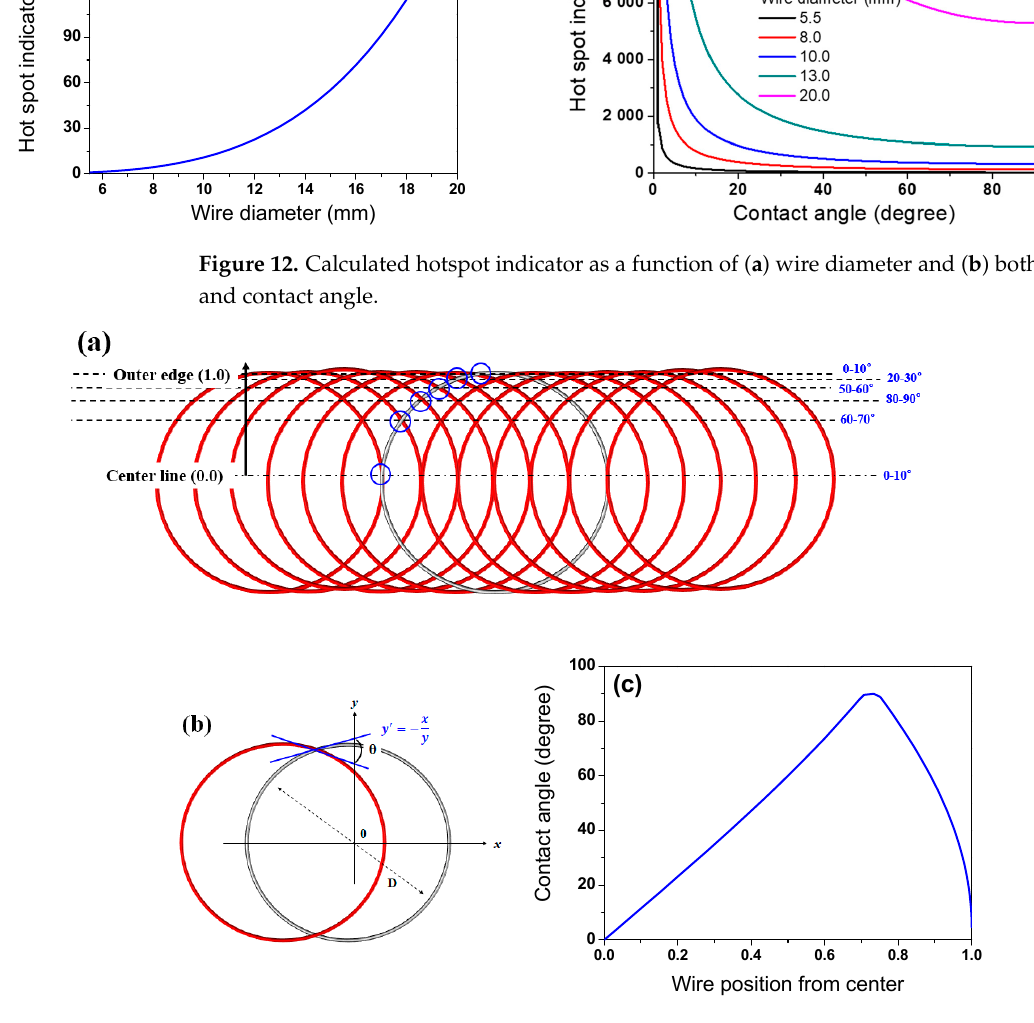
Figure 13. ( a , b ) Schematic of contact angle of wire ring and ( c ) calculated contact angle of wire ring along TD wr during Stelmor cooling.